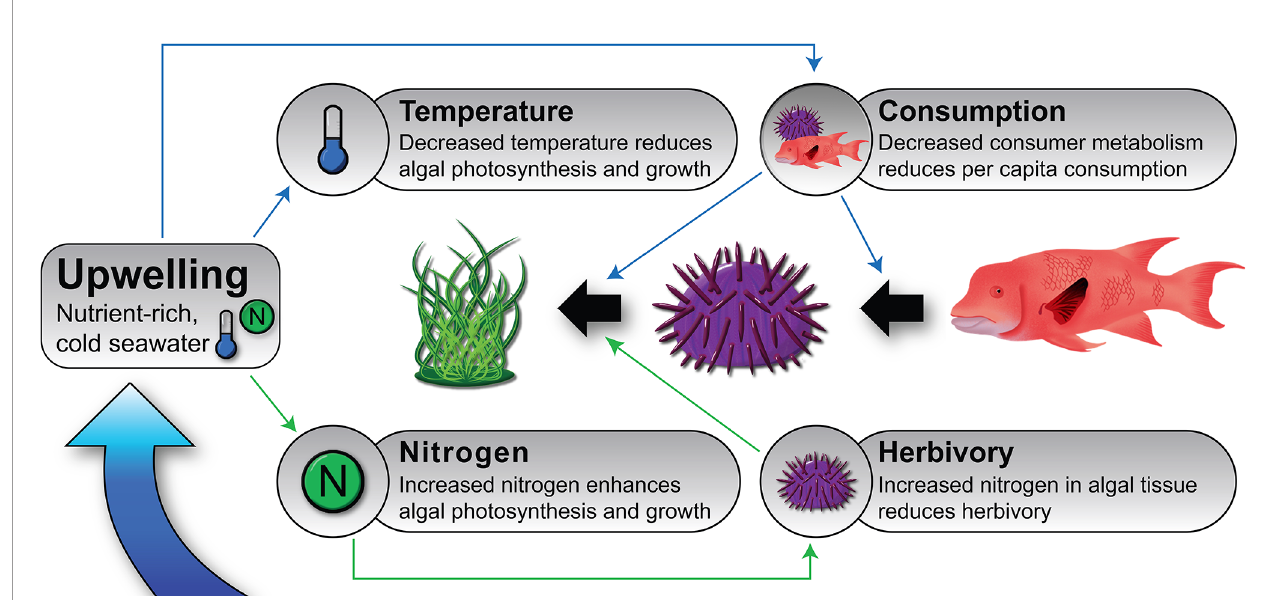
FIGURE 1 | Conceptual model depicting the effects of upwelling on ecological processes and on macroalgal biomass in benthic upwelling communities such as nearshore rocky reefs of the Gala ́ pagos Islands. Black arrows represent trophic interactions, and the narrow, colored arrows represent hypothesized effects of upwelling on some important food web dynamics via enhanced nutrient fl ux (green lines) and lower temperatures (blue lines). Upwelling typically reduces water temperature and increases nutrient fl ux (particularly of nitrate). These environmental modi fi cations cause numerous changes in organismal rates (respiration, photosynthesis, growth, movement, consumption, etc.) and to the per capita strength of consumer – prey interactions. The relative importance and net balance of the in fl uence of upwelling on these and other processes is largely unknown; for example, upwelling should have both negative (via cooling) and positive (via nutrient delivery) effects on primary productivity; the general observation is that prey populations tend to be larger when and where upwelling is strong (Witman et al., 2010). Not every possible effect is included in this model; for instance, enhanced prey growth and density caused by greater resource fl ux could increase the fi tness and abundance of consumers through donor